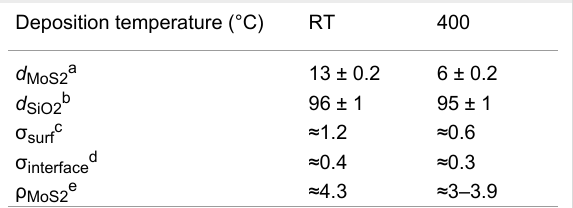
curves (not shown here) the surface roughness ( σ surf ) is ≈ 1.2 nm for the RT film and ≈ 0.6 nm for films deposited at 400 °C.